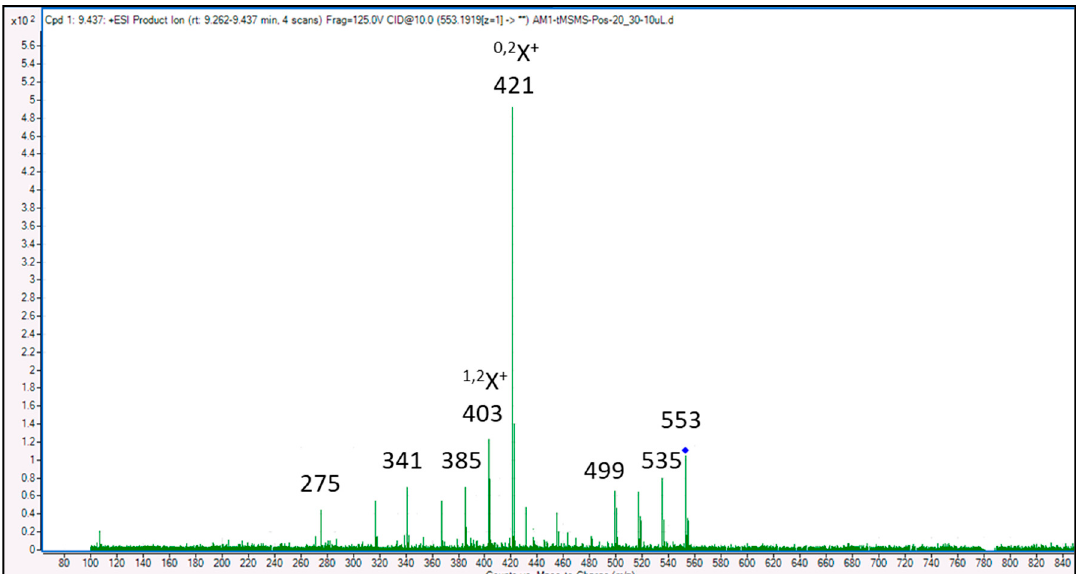
Figure 4. MS/MS spectrum of cucumerin A.